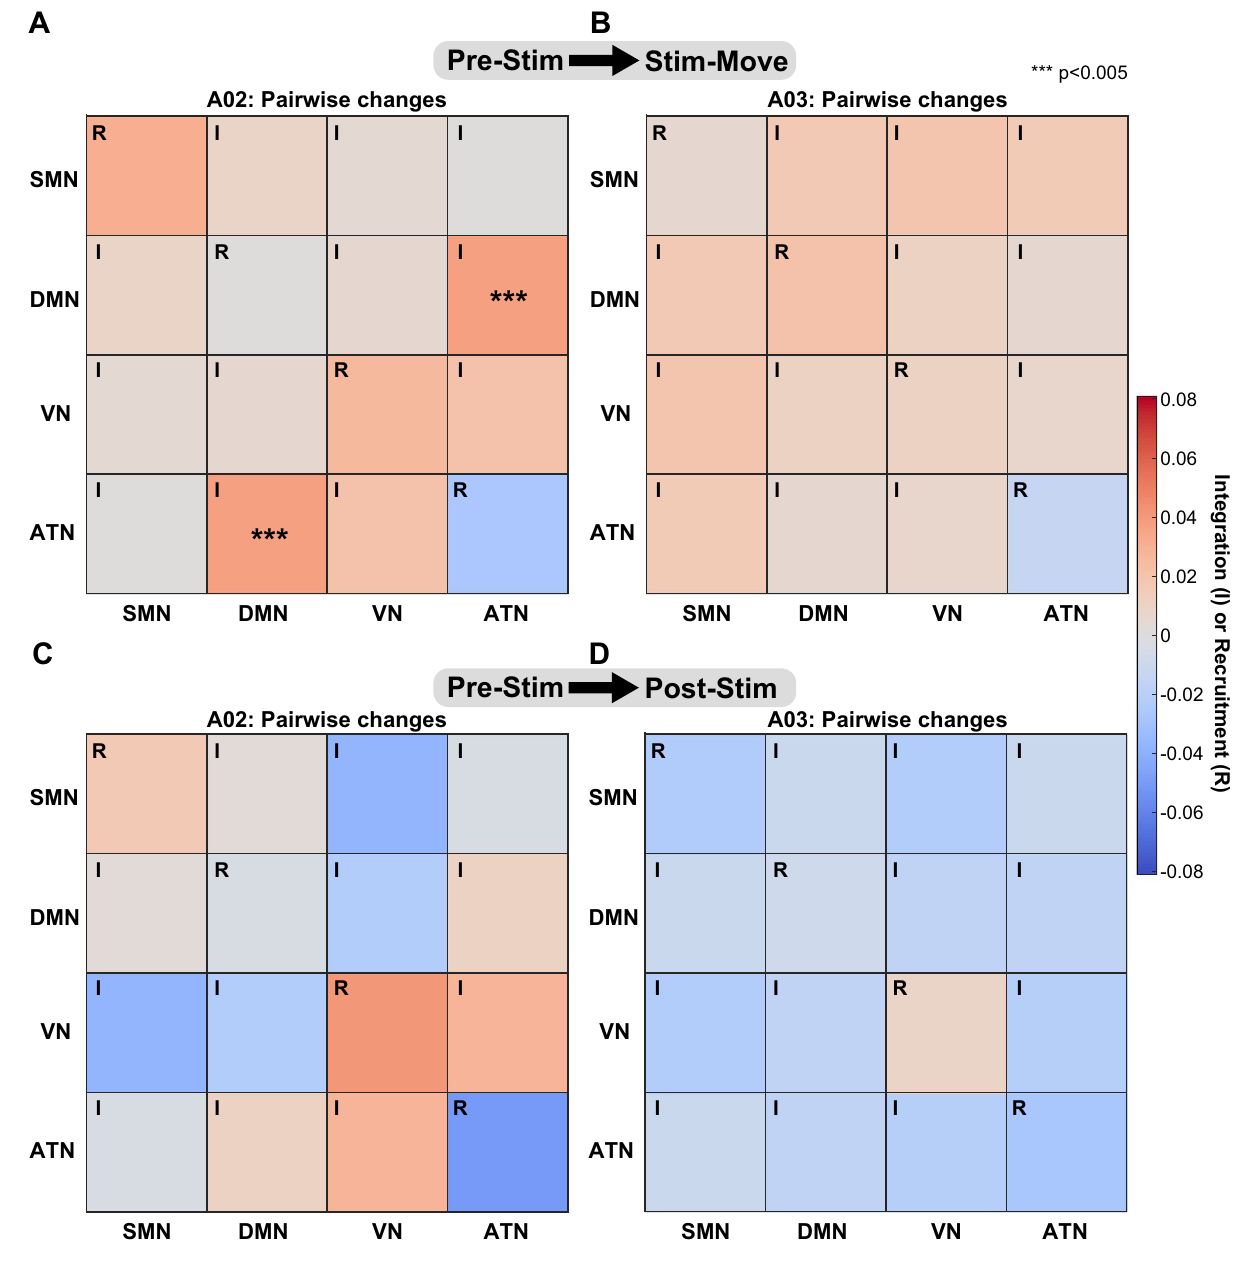
Figure 7. Changes in integration and recruitment of large-scale systems for participants A02 (A, C) and A03 (B, D). ( A ), ( B ) Comparing Stim-Move with Pre-Stim, pairwise integration generally increased. Recruitment of SMN, DMN, and VN increased and that of ATN decreased. ( A ) Integration between DMN and ATN increased with statistical significance for participant A02. ( C ), ( D ) Comparison between Post-Stim and Pre- Stim conditions. ( A )–( D ) Each square plots the average absolute change in integration (I) or recruitment (R) compared to Pre-Stim. All matrix plots are symmetric across the diagonal. See Supplementary Table S4 for statistical power